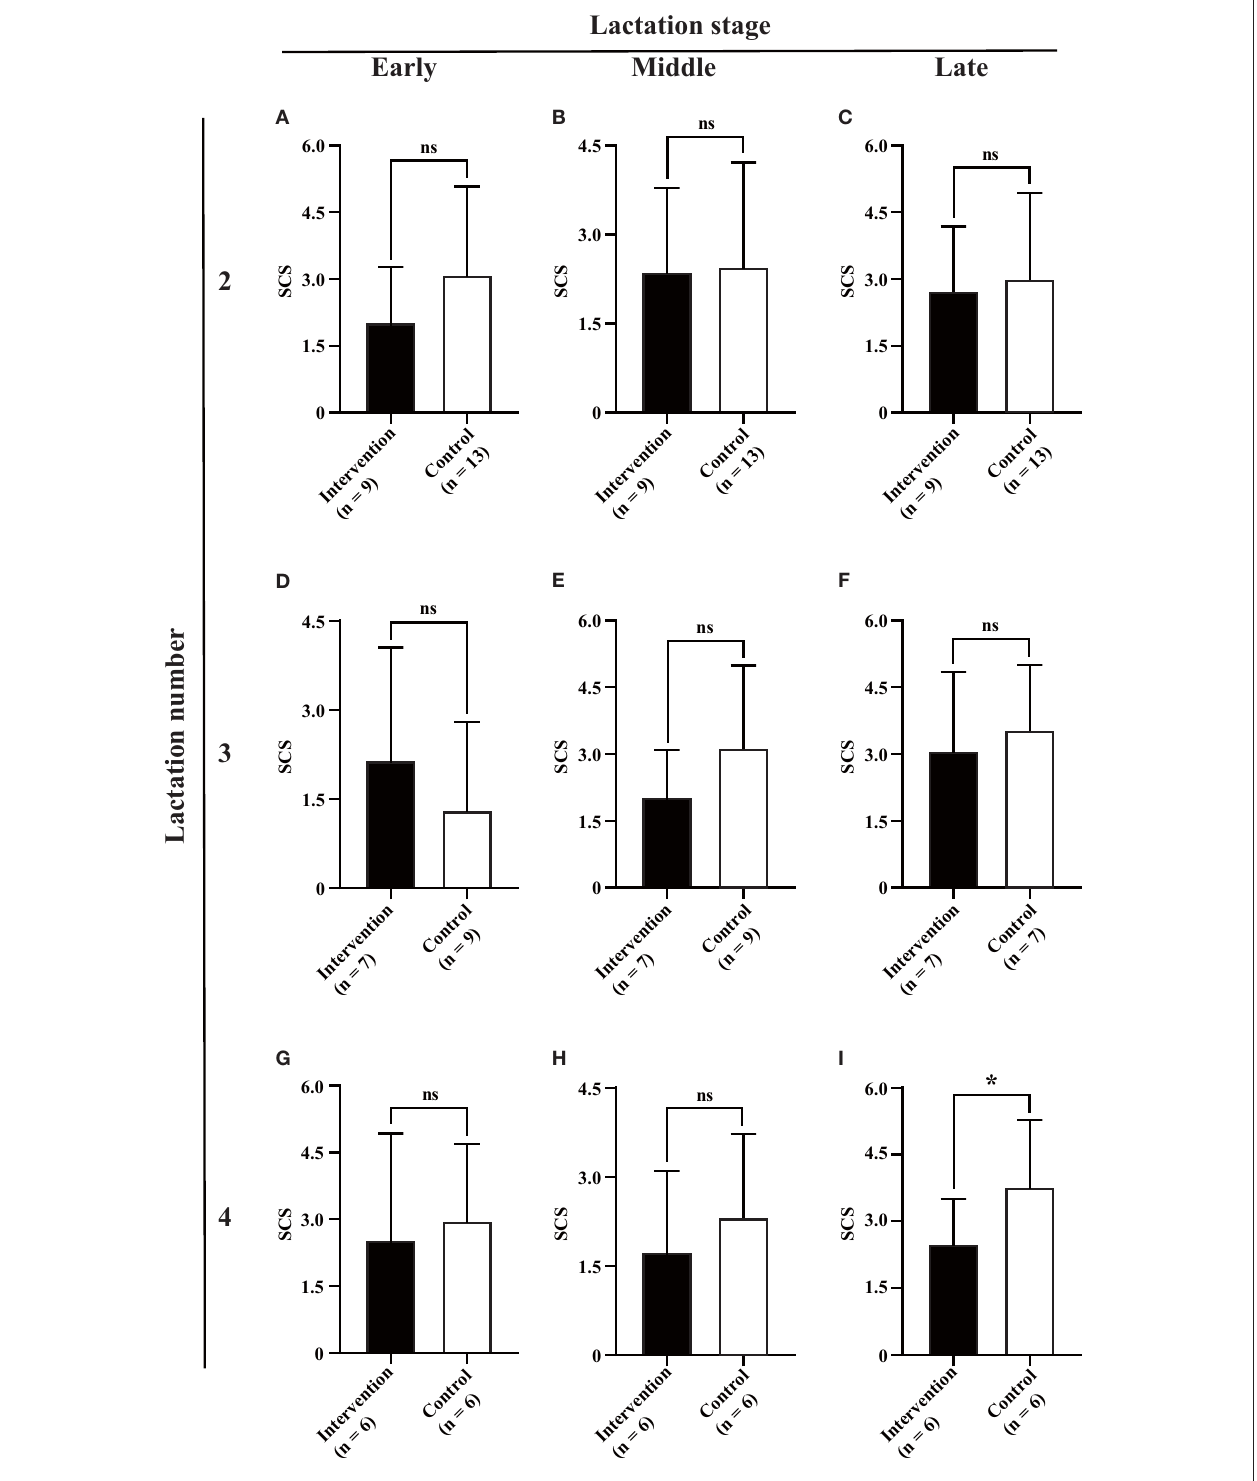
FIGURE 5 | Association between BLV infection and milk SCS. Average monthly milk SCS (A–I) for each of three lactation numbers (2, 3, and 4) and stages (early, middle, and late) was compared between the intervention (in black) and control (in white) groups by Student’s t -test. Data are shown as mean ± SD, and the symbols indicate P ≤ 0.050 (*) and P > 0.050 (ns), respectively.